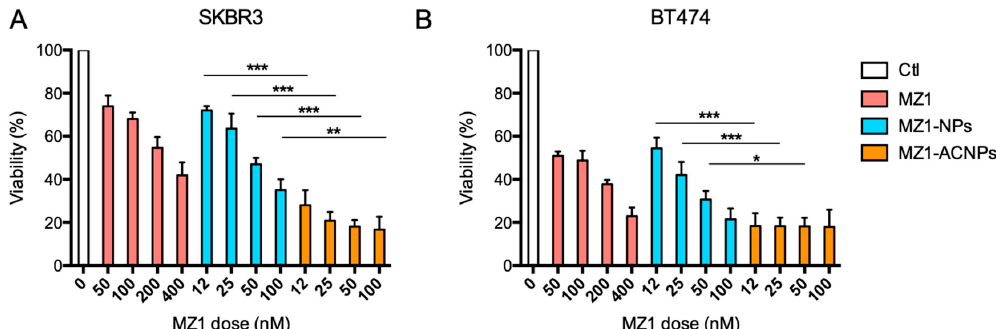
Figure 3. Trastuzumab vectorization increases the antitumor efficacy of MZ1-carrying nanoparticles. Cell viability (in %, referred to the DMSO vehicle) by MTT assay under treatment with control (Ctl) free MZ1, MZ1-NPs or MZ1-ACNPs in SKBR3 ( A ) and BT474 ( B ) HER2+ cell lines. * p < 0.05; ** p < 0.01; *** p < 0.001.